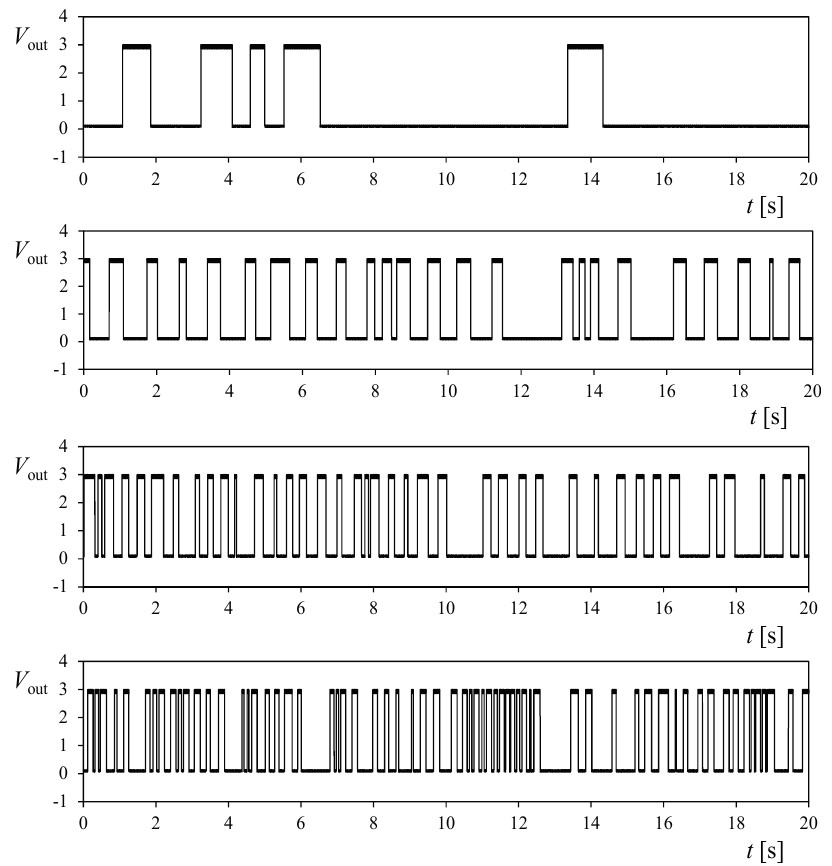
Figure 18. Voltage output, V out , of Climatronics 100075 anemometer equipped with the 1-missing-cup damaged rotor at stabilized position. Sampling during 20 s at 10,000 Hz, for (from Top to Bottom ) V = 1.13, 3.48, 5.83 and 8.18 m·s − 1 wind